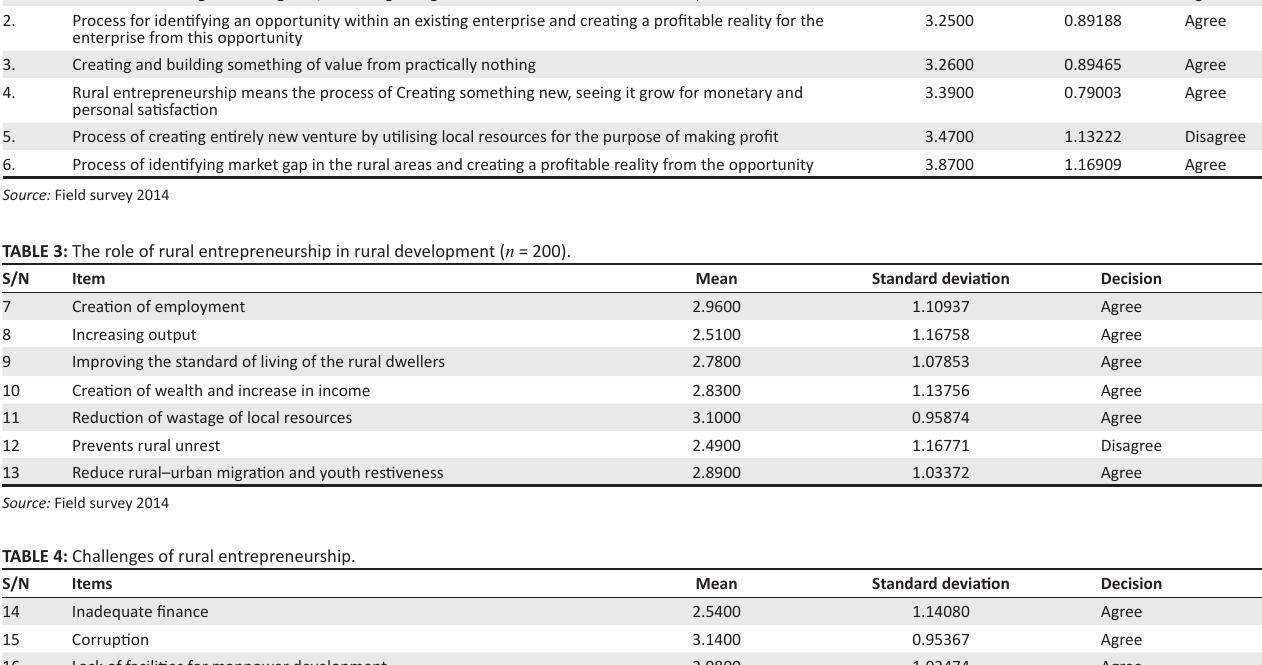
TABLE 2: Understanding the meaning of entrepreneurship and rural entrepreneurship ( n = 200). S/n Item